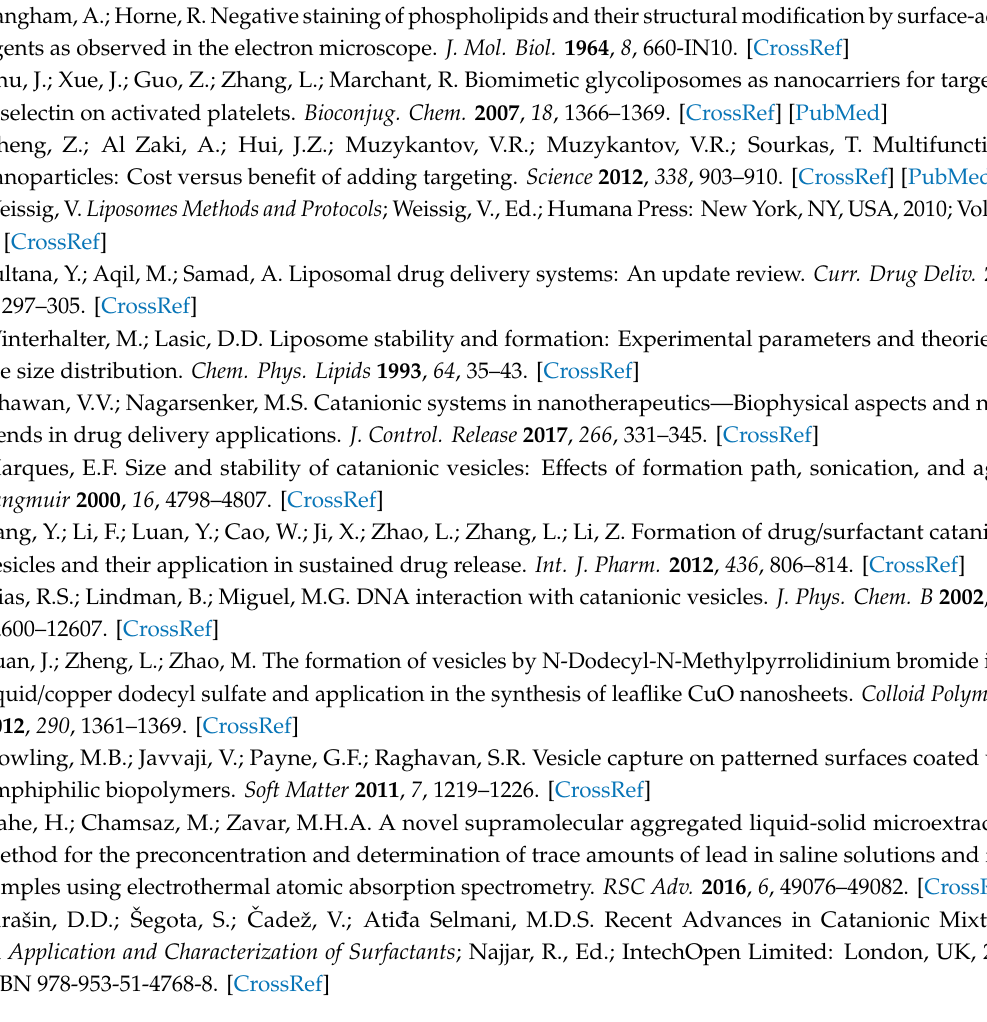
Table S1: Mean diameter, polydispersity index, ς -potential values and visual appearance of the catanionic mixtures at day 20. Photographs corresponding to the C3L and C3S systems: left 2.8, center 5.5, right 8.2, Table S2: Mean diameter, polydispersity index, z-potential values and visual appearance of the cholesterol containing catanionic mixtures (1 mM) at day 7 and 30. Photographs corresponding to the C3L and C3S systems: left 8.2, center 5.5 and right 2.8, Table S3: MIC values ( µ M) of the pure C3(CA)2, 8-HS and sodium laurate, Table S4: MIC values ( µ M) of catanionic mixtures, Table S5: MIC values ( µ M) of cholesterol containing (10%) catanionic mixture, Table S6: MIC values ( µ M) of cholesterol containing (20%) catanionic mixtures, Table S7: MBC values ( µ M) of cholesterol containing (10%) catanionic mixtures, Table S8: MBC values ( µ M) of cholesterol containing (20%) catanionic mixtures, Table S9: Therapeutic index ( HC 50 / MIC ) for the pure gemini surfactant and its catanaionic mixtures. The green columns correspond to formulations which improve the bacterial selectivity of the gemini surfactant, Figure S1: Ethidium bromide exclusion experiments for LAM, C 3 (CA) 2 and their catanionic